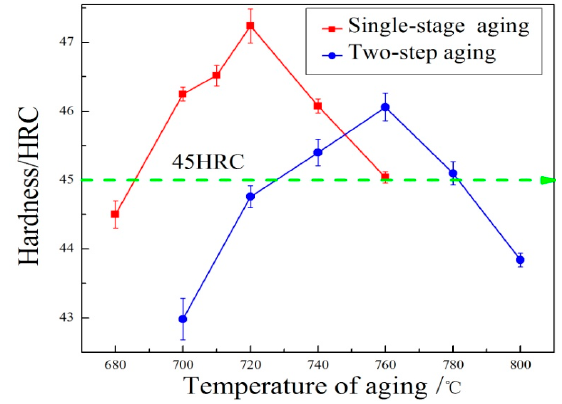
Figure 10. Hardness of specimens with different aging heat treatment processes.